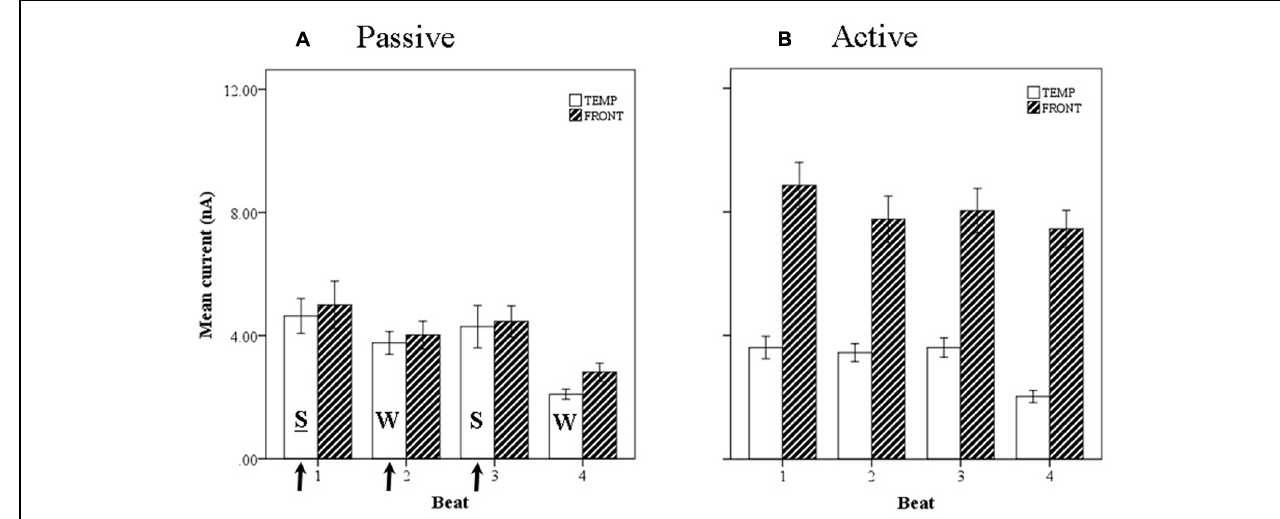
FIGURE 11 | Marginal means of source currents showing the effect of beat position for the mean of frontal and temporal lobe sources during (A) passive listening and (B) active synchronization. Error bars show